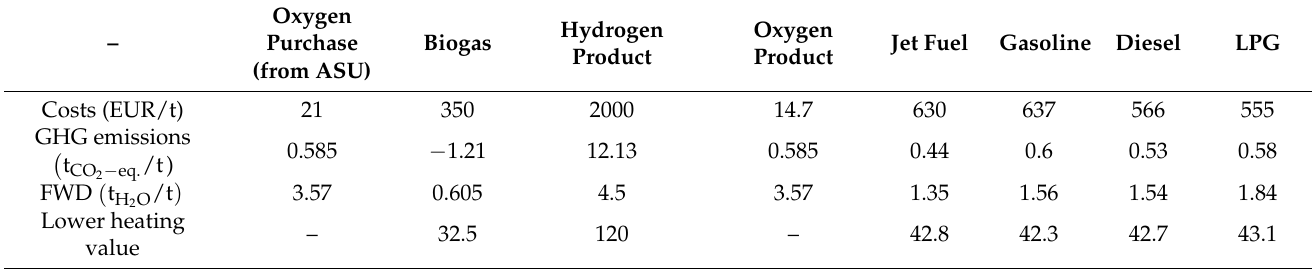
Table 7. Costs, greenhouse gas emissions and fresh water demand for raw materials and by-products (data adapted from